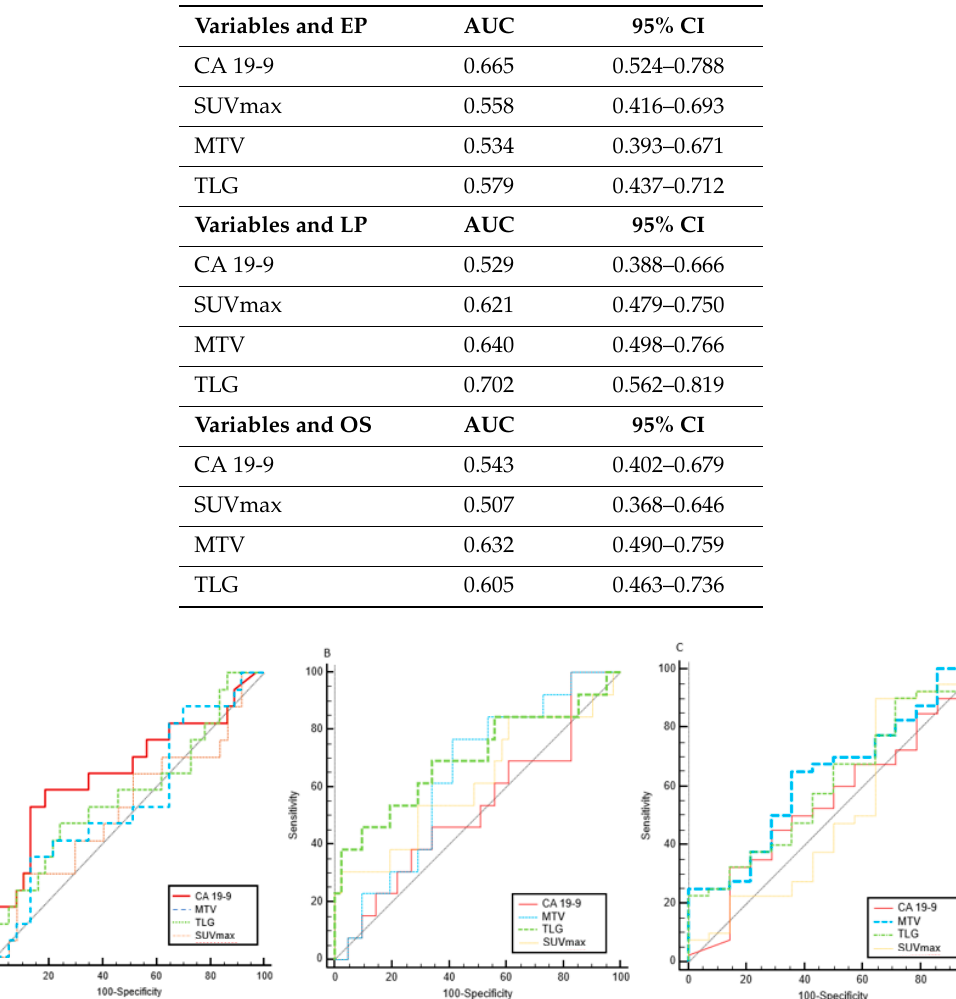
Table 2. Receiver operating characteristic (ROC) analysis for predictors of Early Progression (EP), Local Progression (LP) and Overall Survival (OS). The variables analyzed were CA 19-9 levels, the maximum standardized uptake value (SUVmax), the metabolic tumour volume (MTV), the total lesion glycolysis (TLG) of primary tumours. AUC, area under curve; CI, confidence interval. ns, not significant.